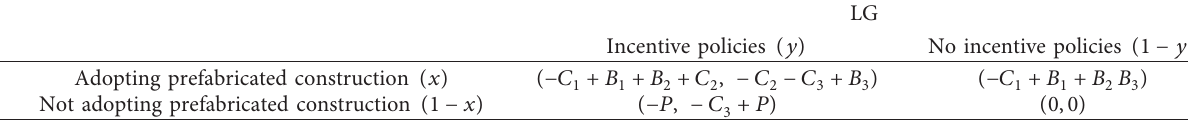
Table 1: Game matrix between the CC and LG for prefabricated construction